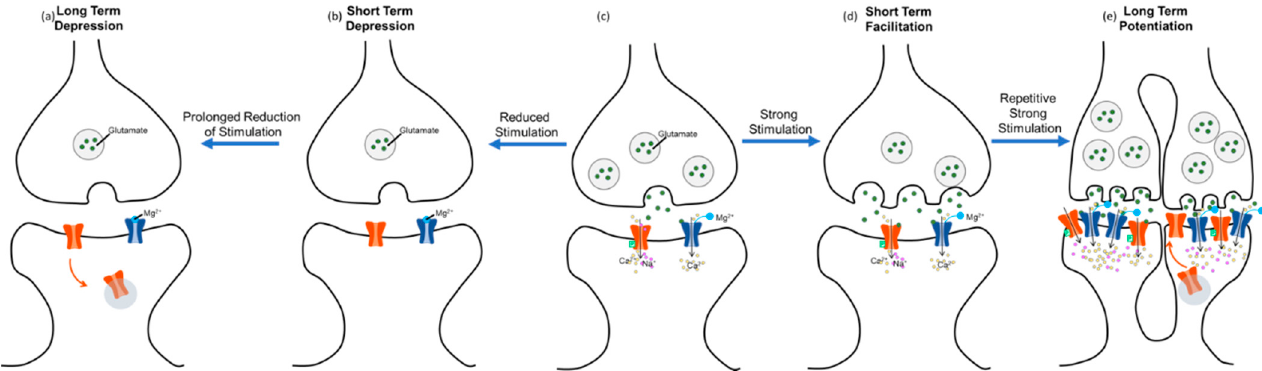
Figure 2. Synaptic Plasticity in Long ‐ Term Potentiation (LTP) and Long ‐ Term Depression (LTD). This figure depicts the cellular mechanisms of LTP and LTD starting from ( c ). During LTP ( c – e ), more frequent and greater stimulation releases glutamate form the presynaptic terminal, which binds to and opens AMPARs letting Na + and Ca 2+ enter the post ‐ synaptic dendrite to depolarize the cell. Sufficient depolarization removes the Mg 2+ from the NMDAR, which is also opened by glutamate, so that the NDMARs can detect the coincidence of activation between the two neurons and allow even greater influx of Ca 2+ and Na + . This high concentration of intracellular Ca 2+ leads to kinase activation, which in turn leads to the phosphorylation of AMPARs. Phosphorylated AMPARs stay open longer when glutamate binds, and more AMPARs are brought to the plasma membrane. Repetition of this process eventually leads to synaptogenesis. During LTD ( a , b ), less frequent and smaller release of glutamate binds to fewer receptors leading to a reduced influx of Ca and Na and prevents the removal of the Mg 2+ plug. Lower Ca levels lead to phosphatase activation and the dephosphorylation of AMPARs, resulting in less time open and the internalization of Inactive AMPARS. LTD often leads to pruning of extraneous synapses.